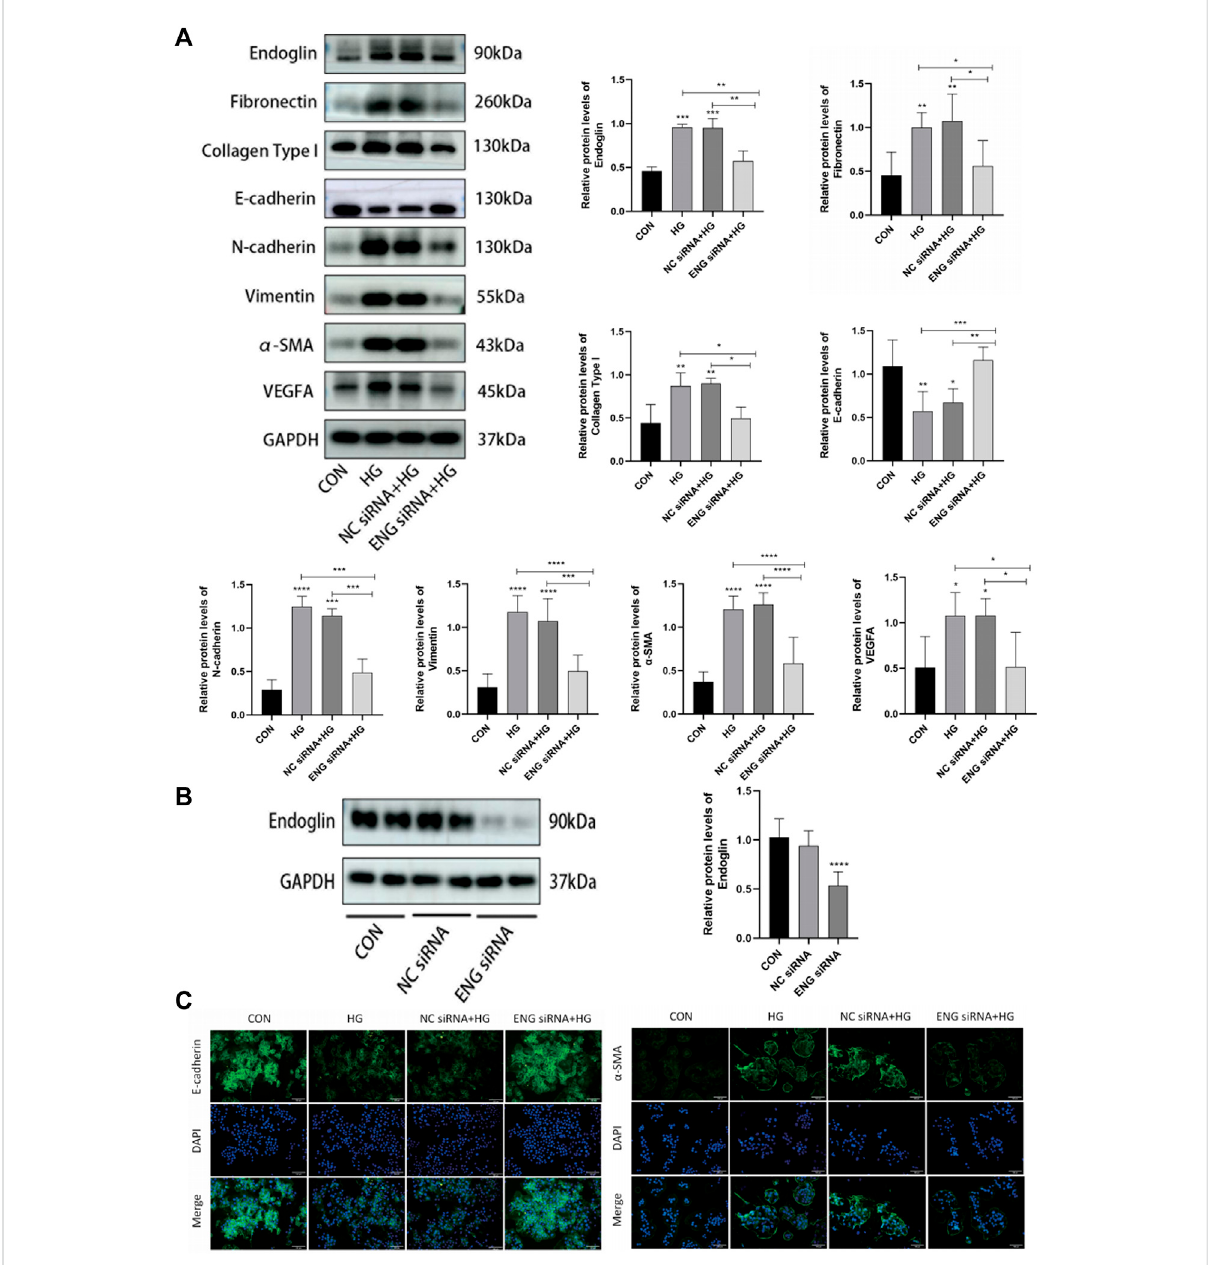
FIGURE 6 Downregulation of endoglin improved HG-induced injury in HPMCs. (A) Western blot detection of endoglin, Fibronectin, Collagen Type I, E-cadherin, N-cadherin, vimentin, α -SMA and VEGFA in HPMCs. GAPDH was used as a loading control. (B) HPMCs were treated with ENG siRNA or NC siRNA, the knockdownef fi ciency was examined by Western blot. (Data are shown as mean ± SD, **** p < 0.0001 comparedwith thecontrol). (C) Representative immuno fl uorescence images of E-cadherin and α -SMA in HPMCs. Scale bar = 100 μ